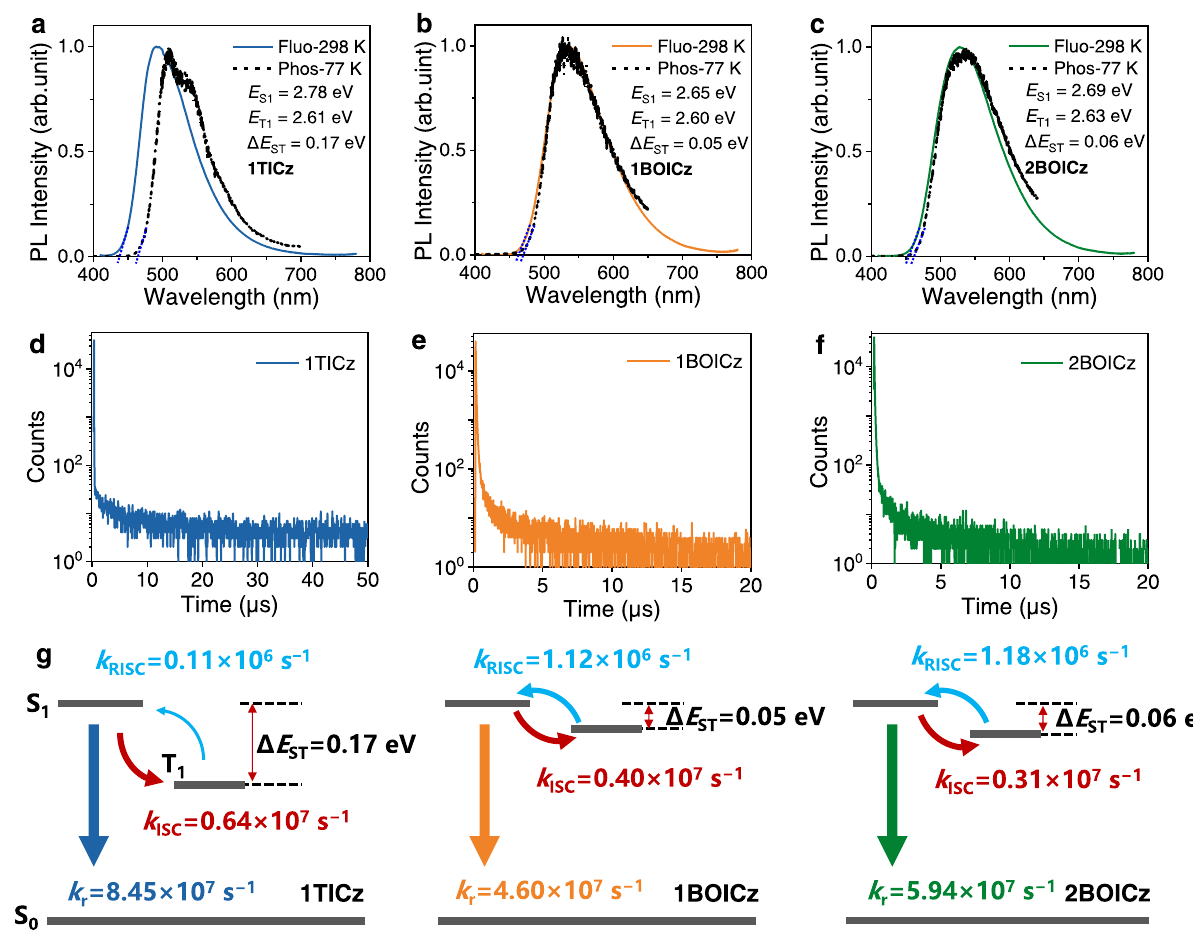
Fig. 2 | Photophysical properties of 1TICz, 1BOICz, and 2BOICz doped fi lms. a – c Fluorescence (line, 298K) and phosphorescence (dash dot, 77K) spectra of their doped fi lms (20wt% doped fi lms). d – f Transient PL decay curves of their